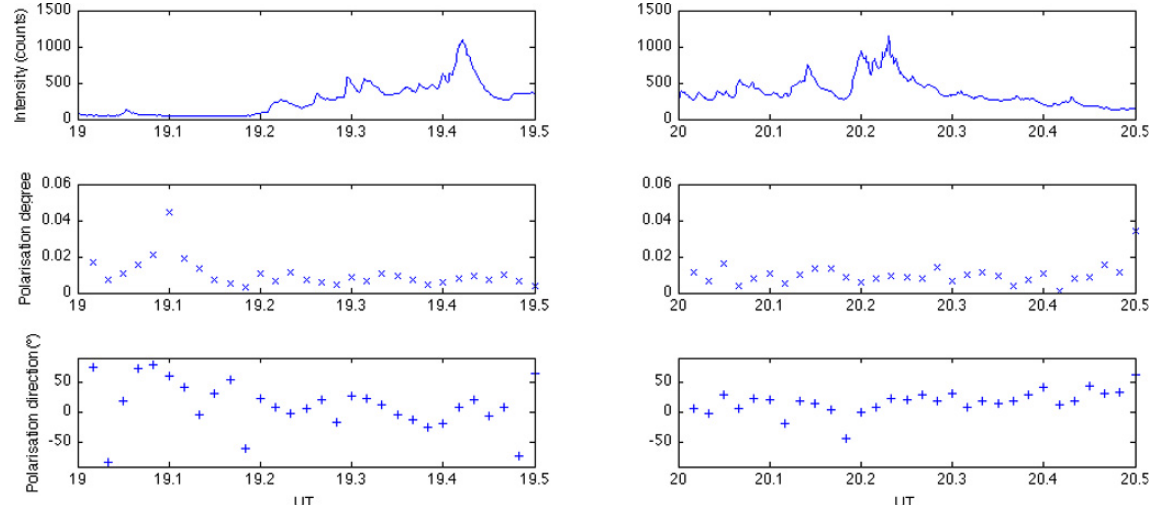
Fig. 8. Zenith optical observations during the first 30 min of each hour (9 January 2008). UT is in decimal hour. Top panel: intensity in counts; mid panel: polarisation degree; bottom panel: polarisation direction in degree from the vertical following the trigonometric direction.